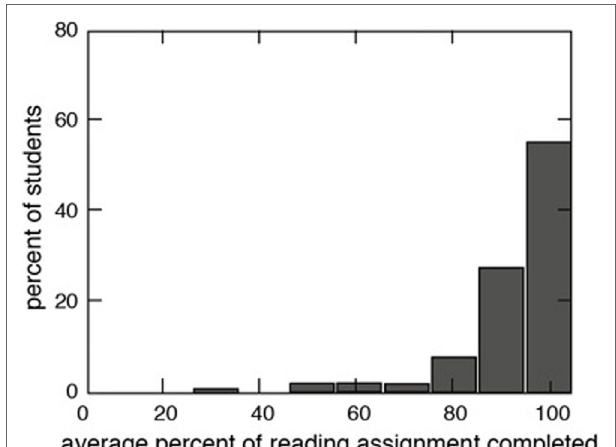
FigUre 10 | Histogram of the average percent of the reading assignment students complete before class.